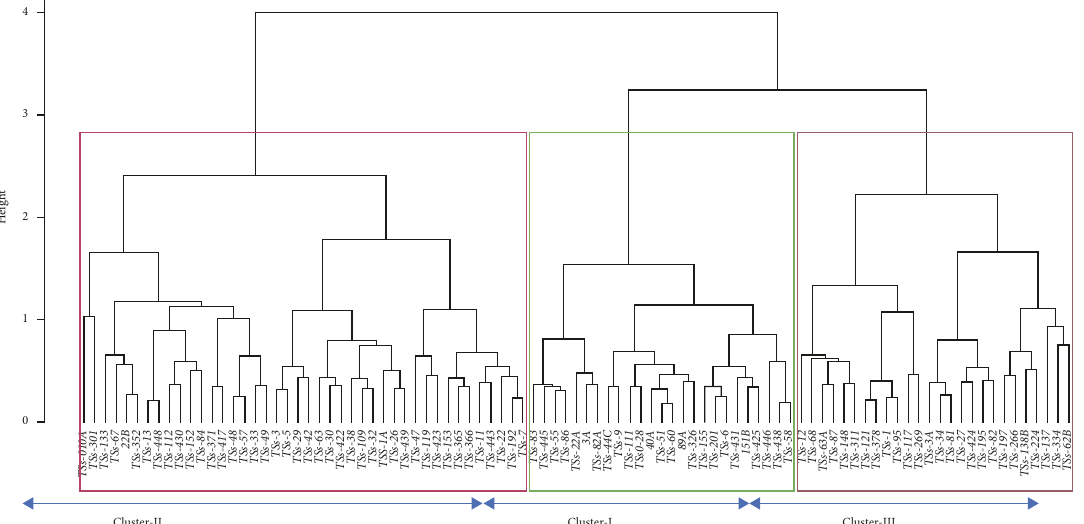
Figure 2: Hierarchical cluster dendrogram based on Gower distance matrix of physical and chemical traits. The dendrogram was created in R software version 4.1.1.